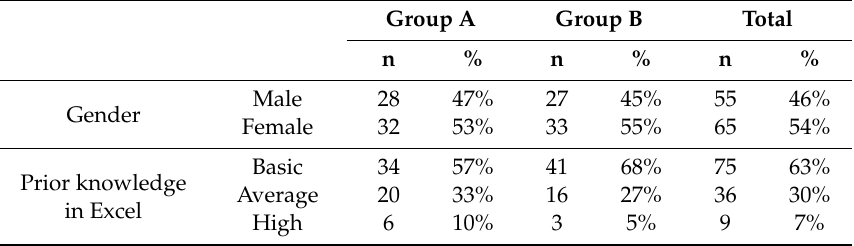
Table 1. Distribution of participants according to gender and prior knowledge.